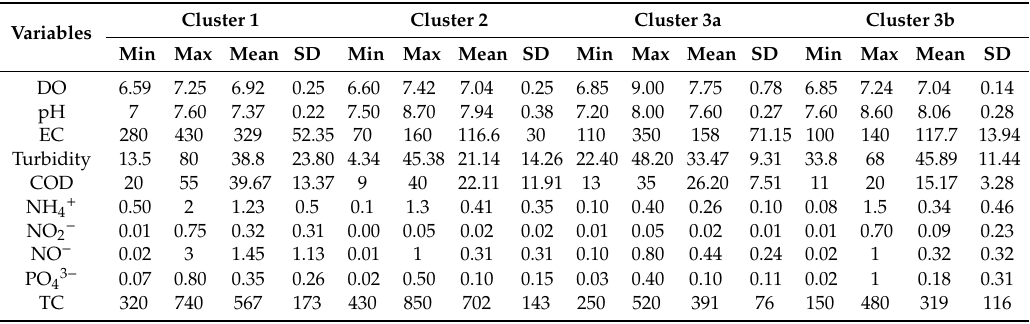
Table A3. Min, Max, Mean and Standard Deviation of water quality parameters at three clusters in the wet